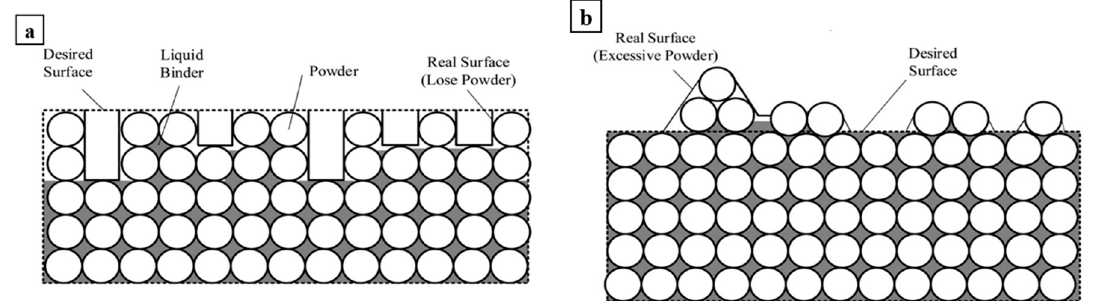
Figure 8. Schematic of printing saturation; ( a ) low printing saturation results in lack of enough binding, ( b ) high saturation results in excessive powder bond [15] .